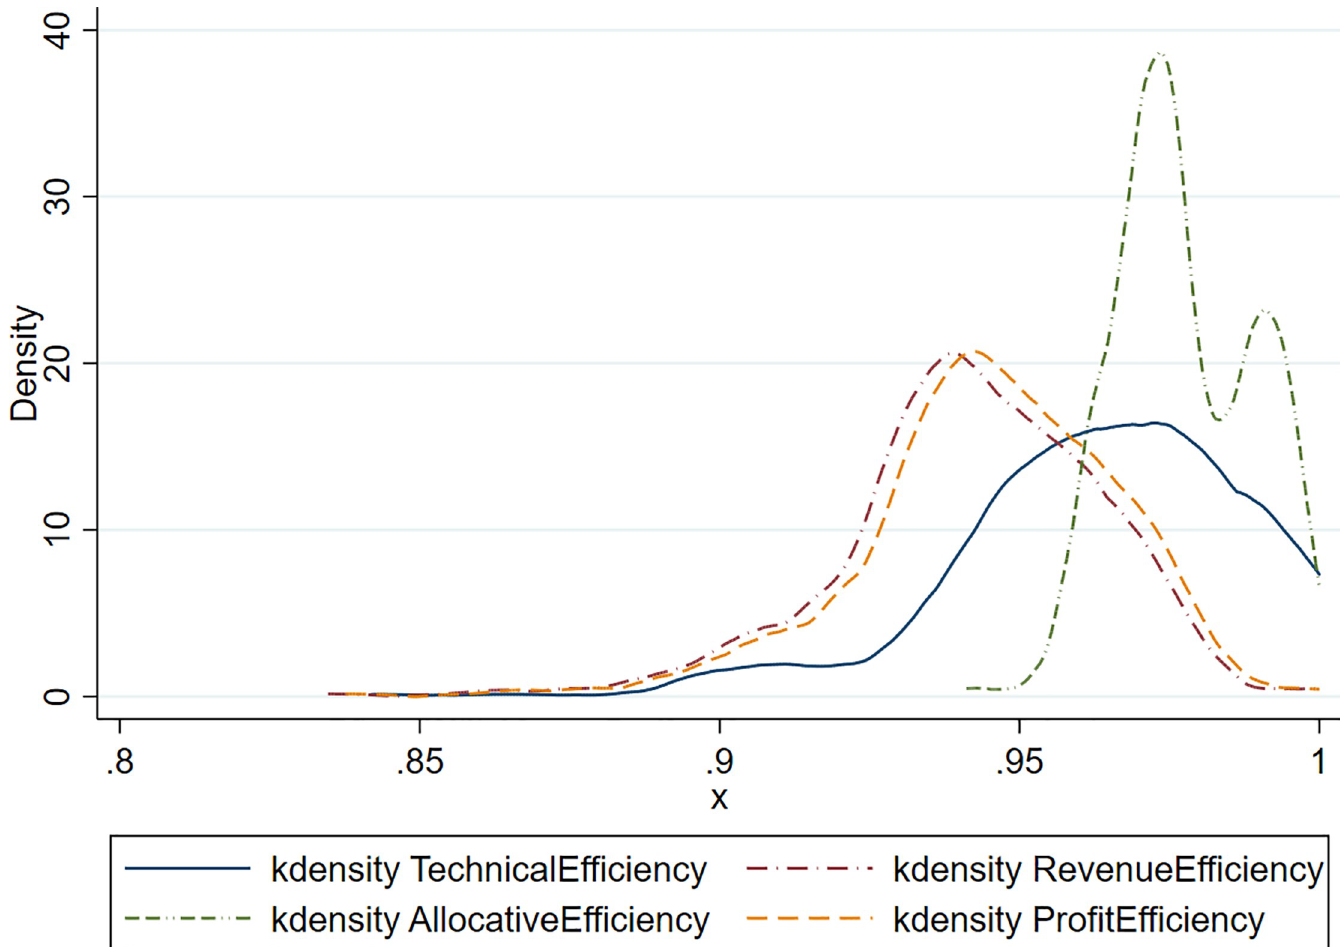
Fig 3. Kernel density estimation of efficiencies including fat, protein and somatic cell count as outputs in FDH model.